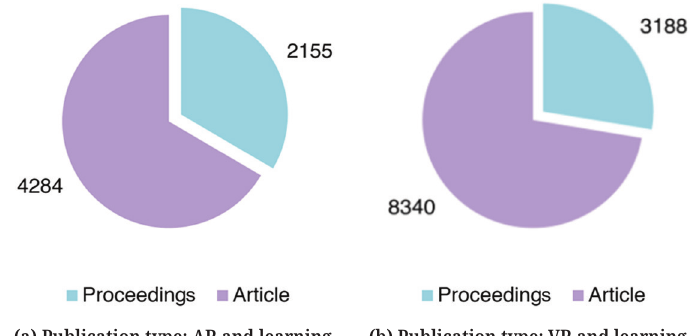
Fig. 3. Publication type: article and proceeding (all year)